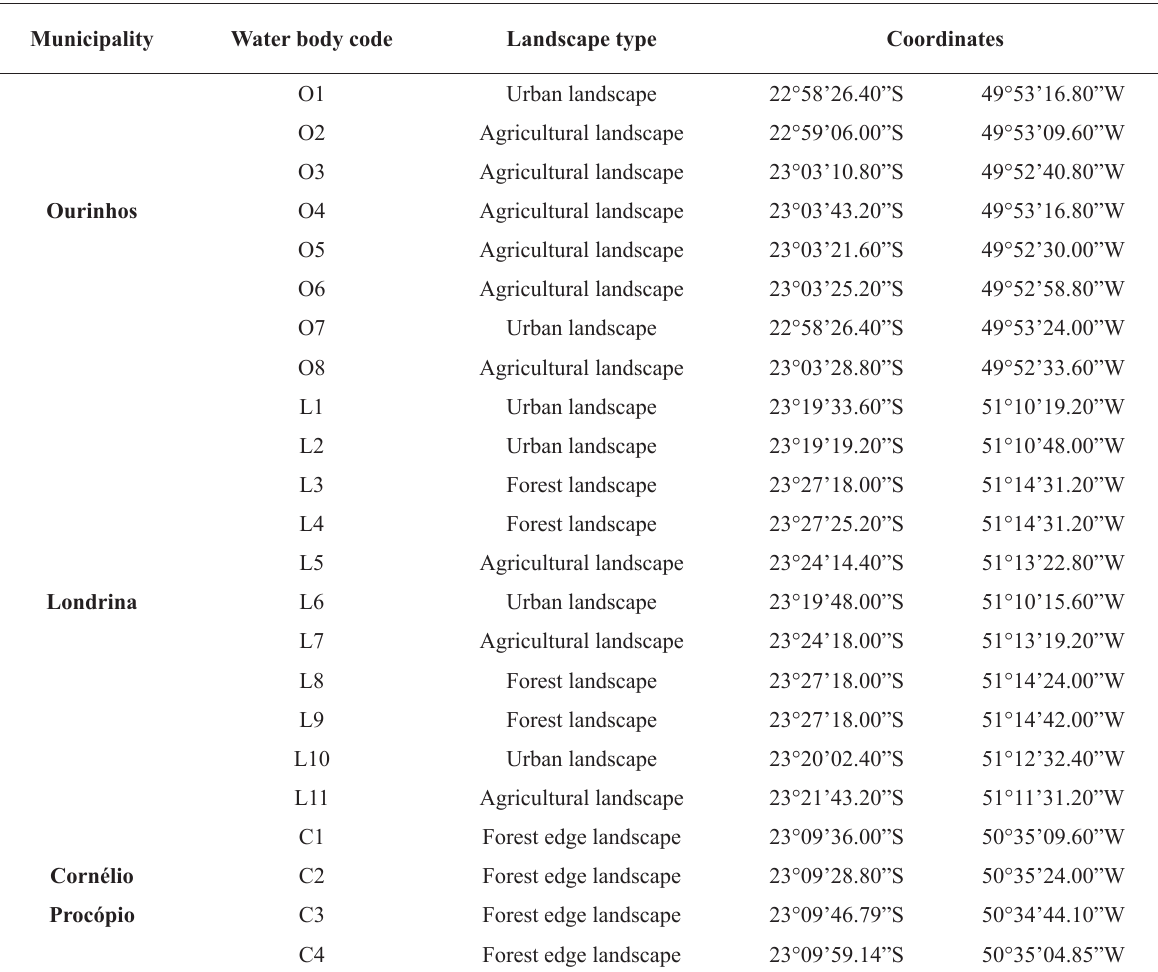
Municipalities, water body code, landscape types, and coordinates of the studied water bodies between October 2010 and February 2011 in northern of the state of Paraná, southern Brazil. The output format of coordinates is in Geographic Coordinate System and datum